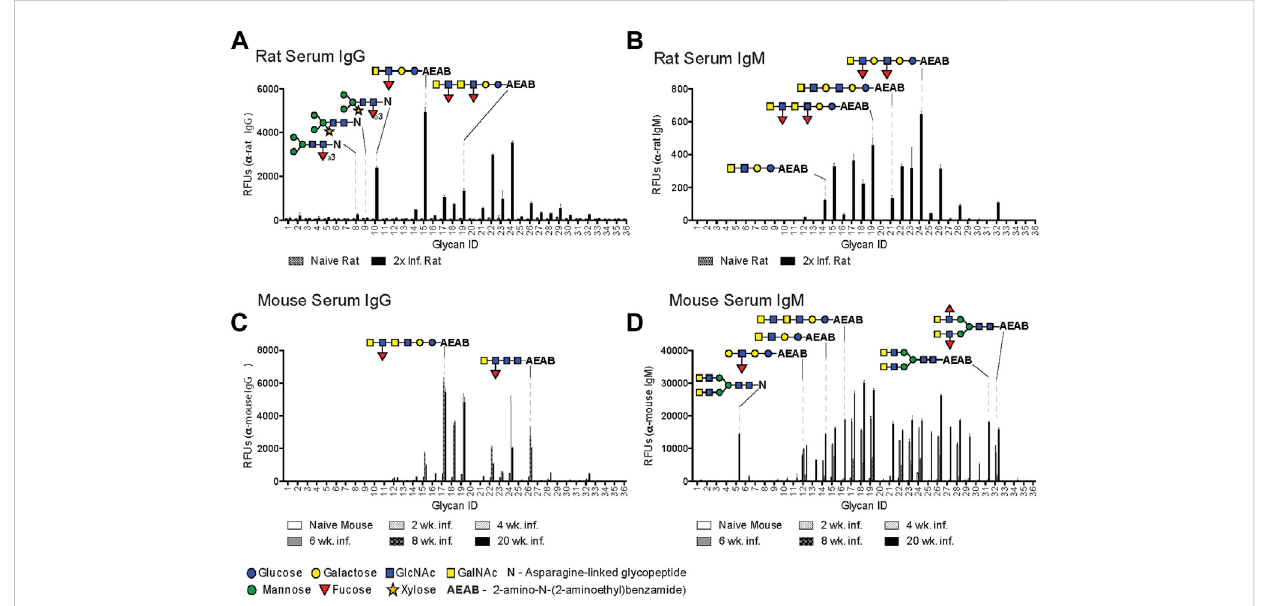
FIGURE 1 Rats generate IgG to core xylose/core α 3 fucose epitope. Schistosoma mansoni twice-infected rat serum (A, B) and mouse sera from various infection time points (C, D) , diluted 1:50 and screened for IgG (A, C) and IgM (B, D) binding to the De fi ned Schistosome-type Array (DSA), and detected with goat anti-mouse IgG-Alexa 488, anti-mouse IgM-Alexa 633, goat anti-rat IgG-Alexa 546, and anti-rat IgM-Alexa 488. Each bar represents an average of binding intensity (relative fl uorescence units, RFU) to tetra-replicate spots for each glycan ID number (listed on X-axis), +/ − 1 standard deviation. Relevant glycan structures depicted, and full list of structures and glycan IDs in Supplementary Figure S1. Glycans are either N-linked (asparagine-linked) or AEAB-linked (bifunctional fl uorescent linker, 2-amino-N-(2-aminoethyl)-benzamide); N-glycopeptides contain 1-4 amino